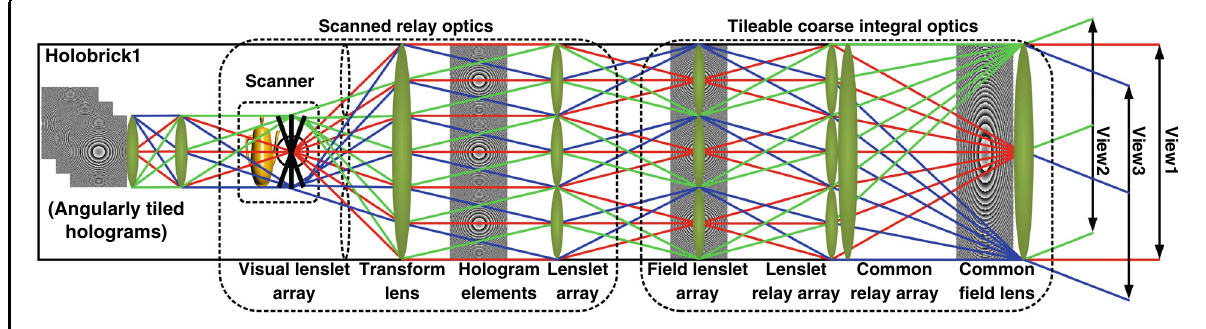
Fig. 2 The schematic of a scanned holobrick with the scanned modular